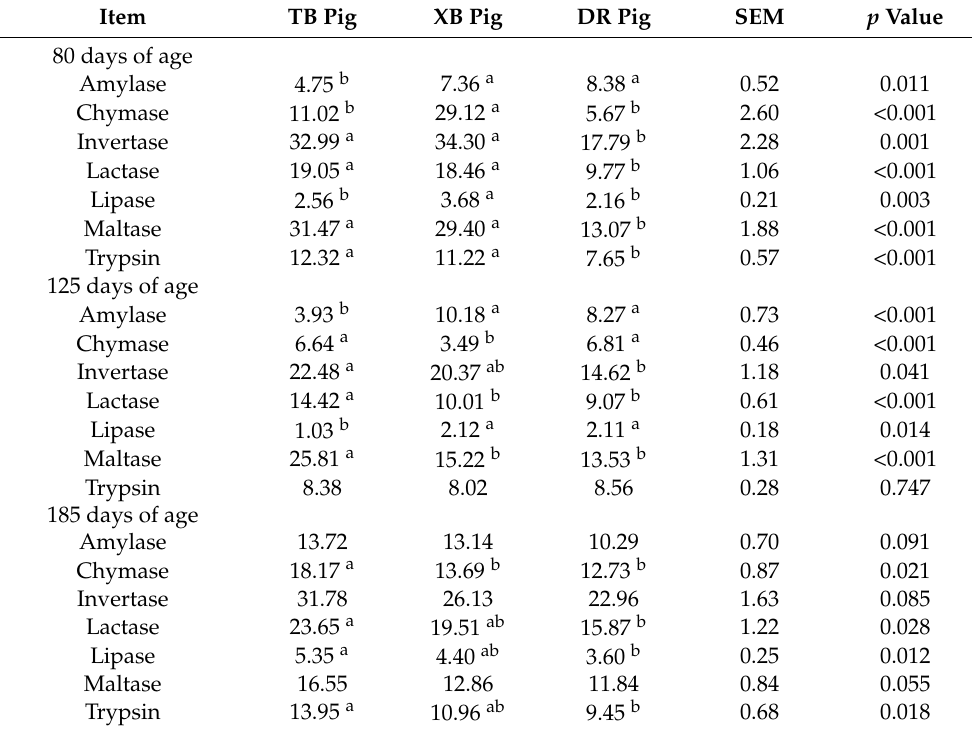
Table 10. Jejunal digestive enzyme activities of three pig breeds at different ages (U/g). Item TB Pig XB Pig DR Pig SEM p Value